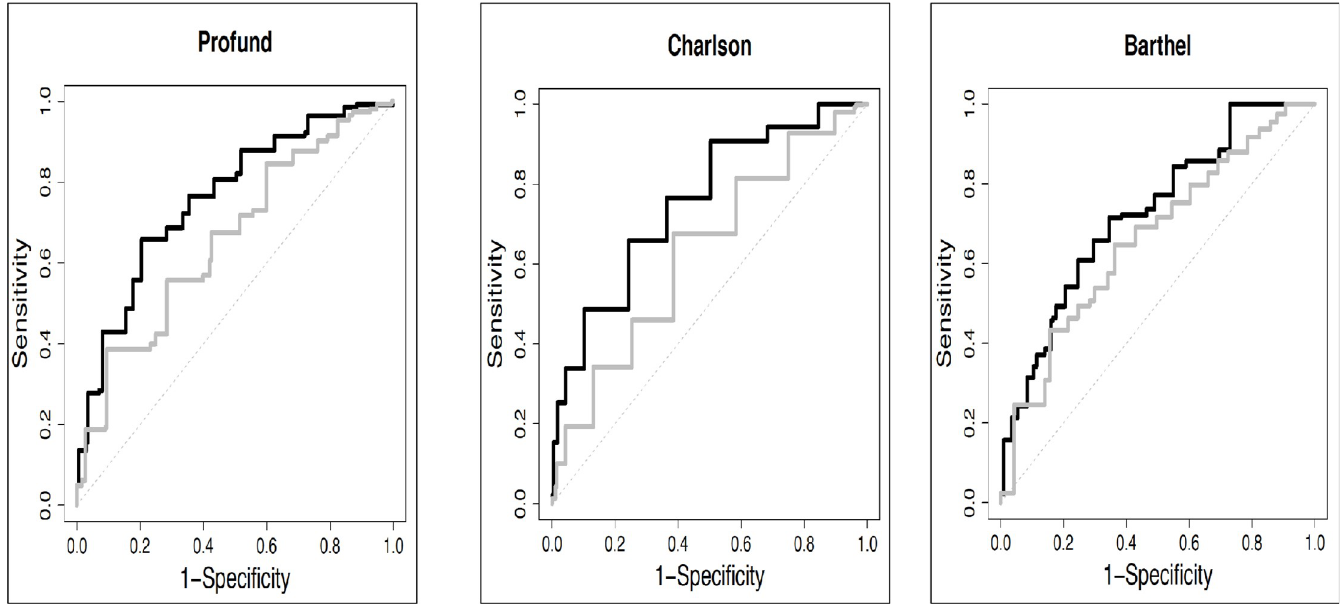
Fig 5. Dynamic cumulative ROC curves and1-year mortality for PROFUND, Charlson index, and Barthel scale. Black = male. Gray = female.